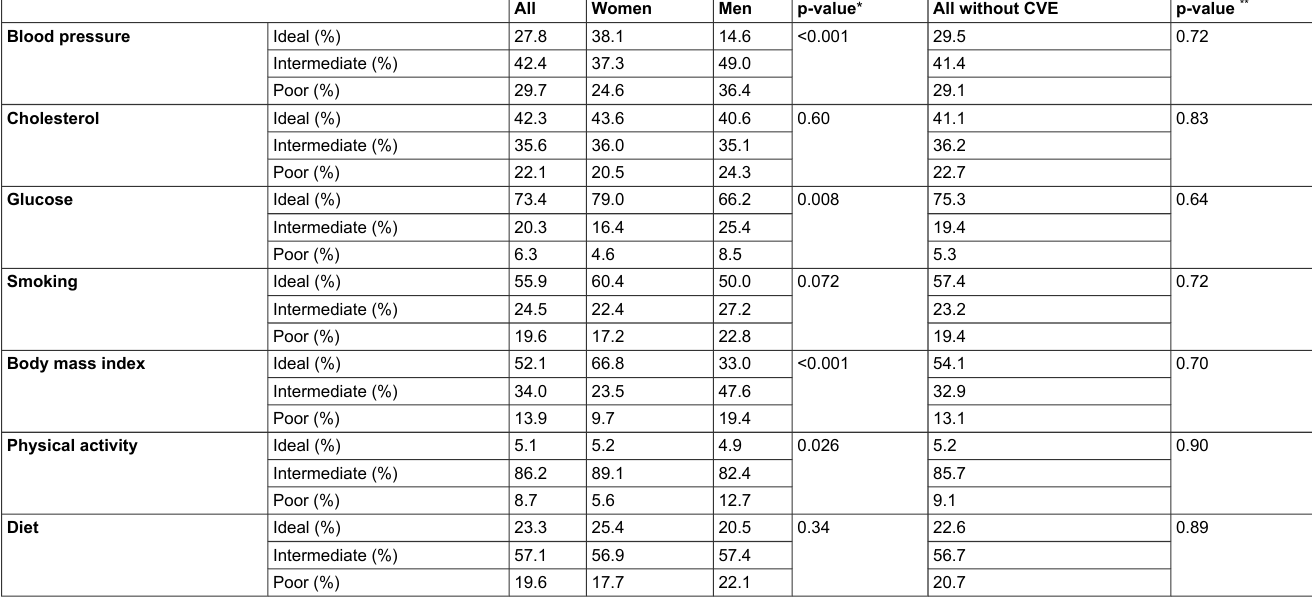
Table 2: Prevalence of the three levels (i.e., ideal, intermediate and poor) of the seven American Heart Association health metrics for the overall study population, separate for women and men, and after exclusion of participants who had a previous cardiovascular event.